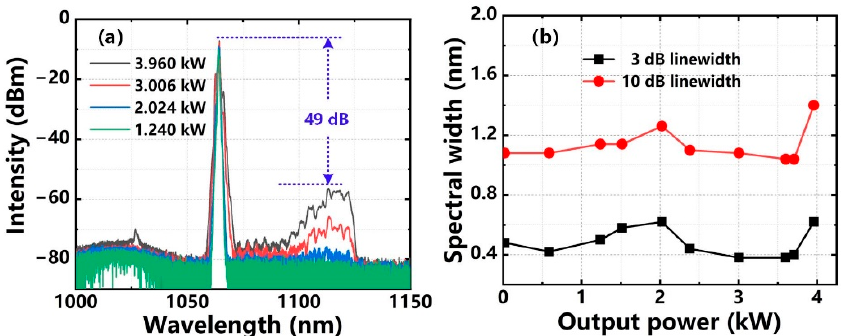
Figure 5. Spectral characteristics of the main amplifier: ( a ) output spectra; ( b ) 3 dB and 10 dB linewidths.